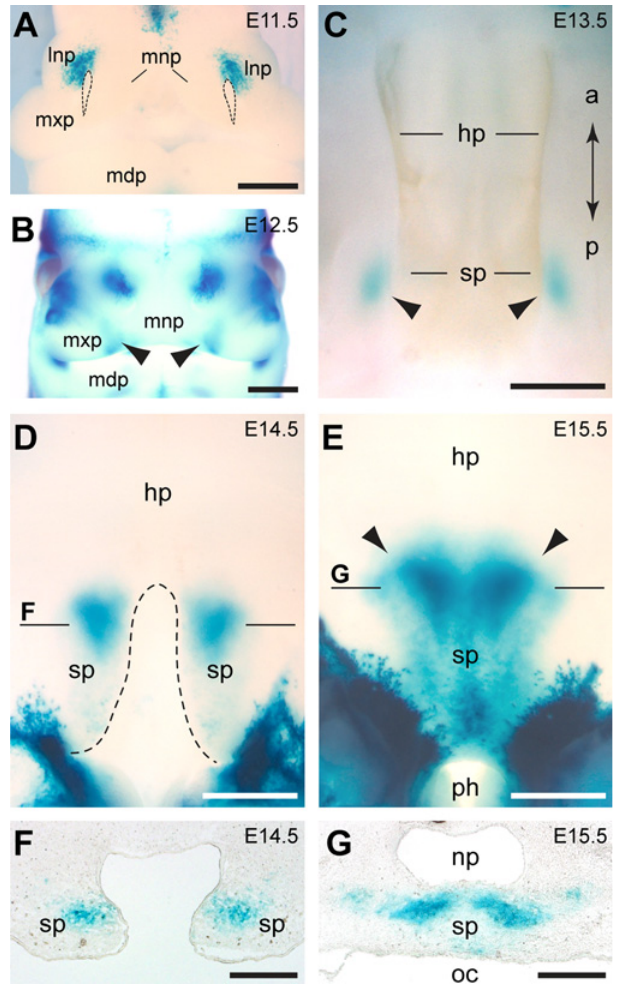
Fig 4. Grem1 expression during mouse craniofacial development. ( A-E ) Expression of Grem1 is visualized by X-Gal staining of heterozygous Grem1 LacZ whole mount embryos. ( A ) At E11.5, Grem1 is expressed in the dorsal part of the lateral nasal prominence (lnp). Stippled lines demarcate the nasal pits. ( B ) At E12.5, Grem1 -positive domains are also detectable in the merging zones (arrowheads) of medial nasal prominences (mnp) and maxillary prominences (mxp). ( C-G ) Secondary palate development. ( C ) At E13.5, Grem1 -positive domains are observed in the forming soft palate (sp). ( D ) At E14.5, the hard palate (hp) has formed while the Grem1 -expressing shelves of the soft palate are not yet fused. ( E ) At E15.5, the soft palate has fused and Grem1 expression extends posterior to the pharynx (ph). Note the sharp anterior boundary of Grem1 expression in the soft palate (arrowheads). ( F, G ) Sections of whole mount stained embryos. ( F ) Cross section at the level indicated in (D) showing that Grem1 expression is restricted to the mesenchyme. ( G ) Cross section at the level indicated in (E) showing Grem1 expression in the soft palate, which separates the nasopharynx (np) from the oral cavity (oc). Additional abbreviations: a, anterior; l, lateral; m, medial; mdp, mandibular prominence; p, posterior. Scale bars: 500 μ